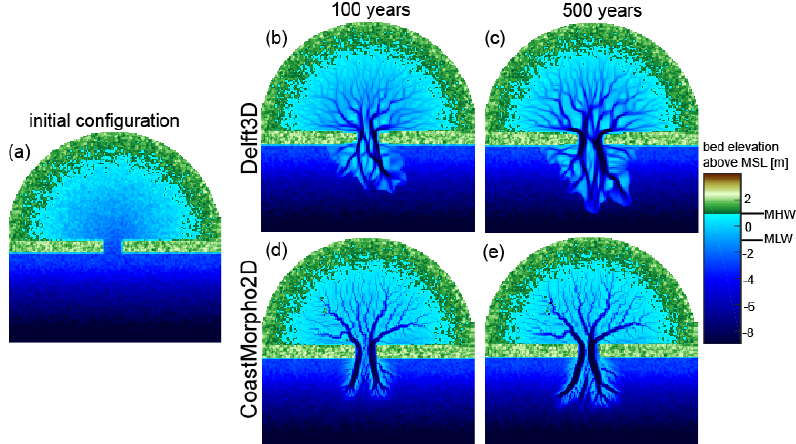
Figure 9. Comparison between Delft3D and CM2D for the reference case (as in Figure 5e), but with an initial inlet width of 1.5 km instead of 3 km. ( a ) Initial configuration; ( b , c ) Results with Delft3D at year 100 and 500; ( d , e ) Results with CM2D at year 100 and 500.